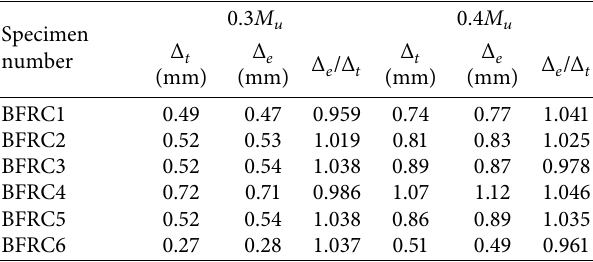
Table 8: Comparison between experimental values and values calculated by the modified